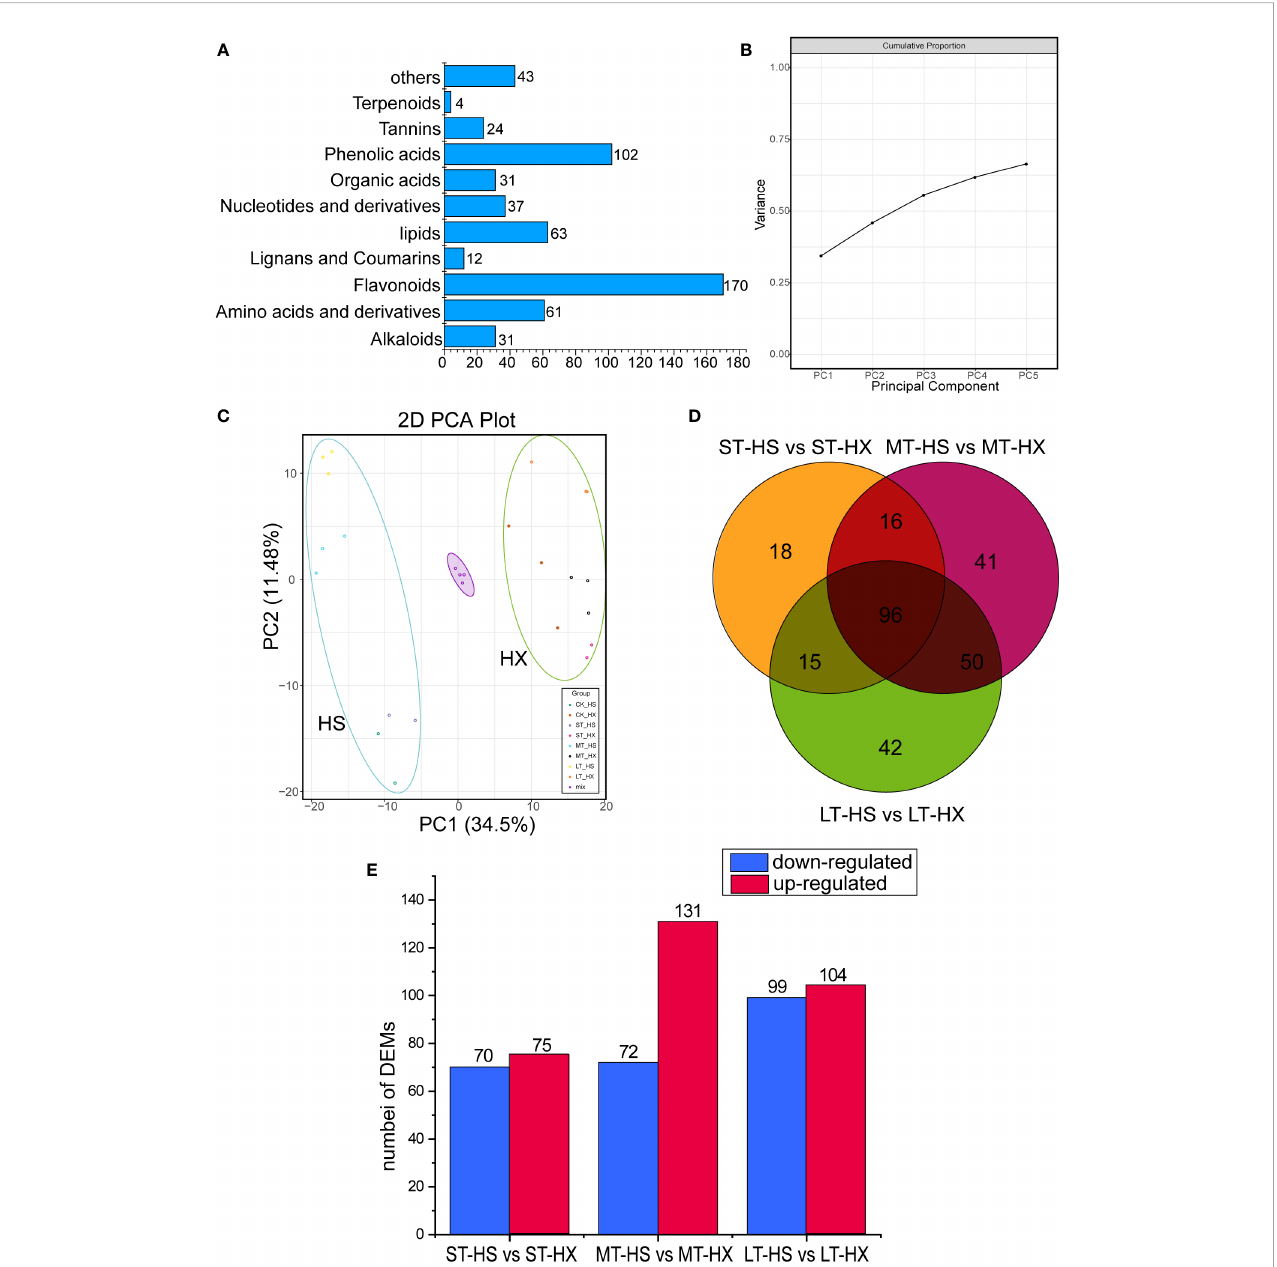
FIGURE 3 Overview and analysis of metabolites. (A) classi fi cation of the 578 metabolites. (B) variance explained by PCs 1 – 5. (C) PCA of metabolome data at the four sampling points (0, 1, 7, and 25 days; three biological replicates per point). (D) Venn diagrams of DEMs under different cold treatments. (E) up- and down regulated